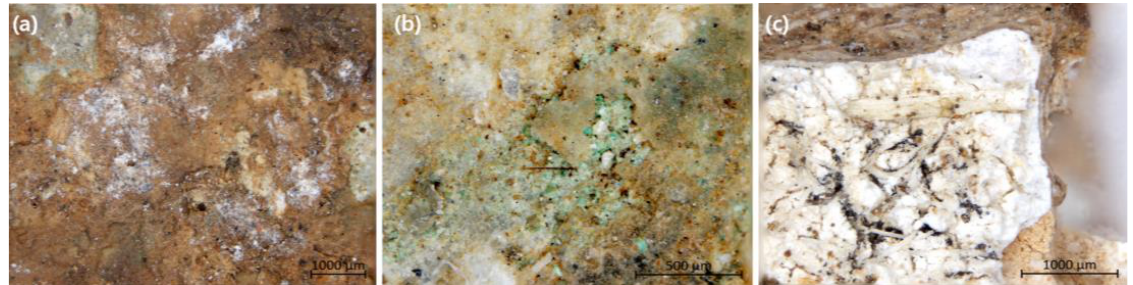
Figure 6. Sample details of mural sample. ( a ) front details: red-brown clay materials and white contaminants, ( b ) front details: status of pigment in painting layer, ( c ) back details: Mixture of lime with materials presumed to be fiber, charcoal, etc.